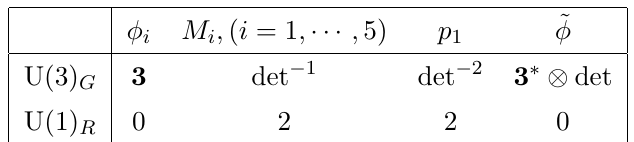
S (cid:3) (cid:10)O (1) (cid:8)O